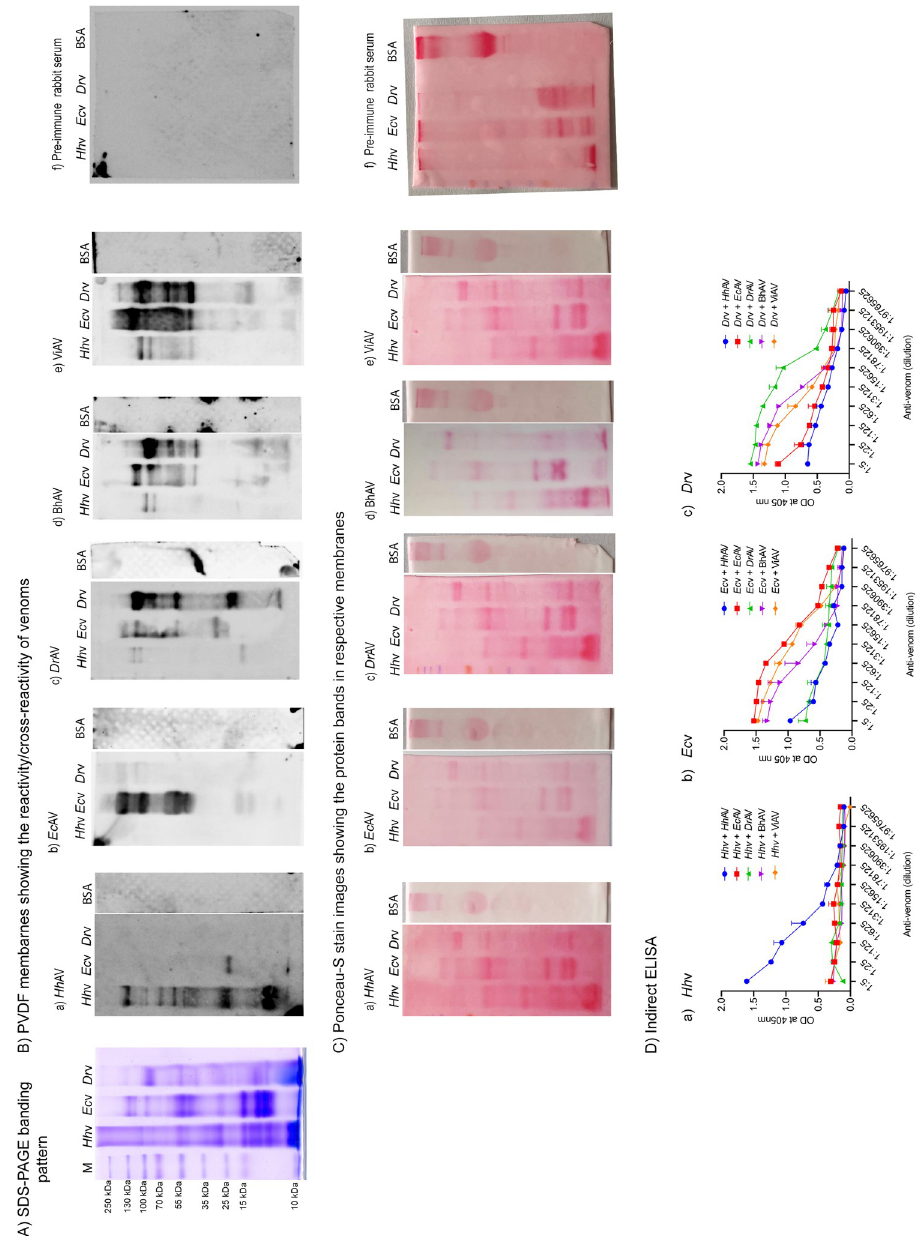
Fig 7. Cross-reactivity of H . hypnale , E . carinatus , and D . russelii venoms with the anti-venoms. (A) SDS-PAGE protein banding pattern of Hh v, Ec v, and Dr v, and M represents the molecular weight protein markers in kDa. (B) Western blots showing reactivity/cross-reactivity of Hh AV (Ba), Ec AV (Bb), Dr AV (Bc), BhAV (Bd), ViAV (Be), and pre-immune rabbit serum (Bf) with Hh v, Ec v, and Dr v. BSA, 25 μ g was used as a negative control. (C) Corresponding Ponceau-S stain images showing the protein bands in respective membranes when stained before processing with respective anti-venoms in Western blot. In all cases, the electrophoresis was carried out under identical, non-reduced condition in 10% gels. (D) Indirect ELISA titers of Hh v, Ec v, and Dr v with anti-venoms. (Da) Hh v, (Db) Ec v, and (Dc) Dr v. Venoms, 0.1 μ g/100 μ l were independently treated with various dilutions of Hh AV, Ec AV, Dr AV, BhAV, and ViAV. The data is presented as Mean ± SEM (n = 4). (Antiserums, 1 mg/ml were adjusted, and used for dilution in